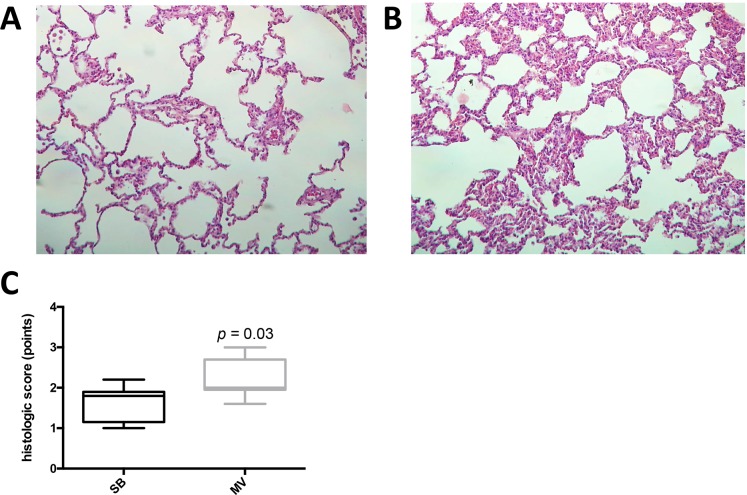
Rabbits exposed to injurious mechanical ventilation present signs of lung injury characterized by massive neutrophil infiltration.Representative lung histology (hematoxylin-eosin stain) in spontaneously breathing rabbits (A) and in rabbits submitted to mechanical ventilation for 4 hours (B). Histological lung injury score in rabbits submitted to mechanical ventilation compared to spontaneously breathing (SB) animals. Tissue injury was scored based on the degree of polymorphonuclear infiltration, hemorrhage, and edema in the interstitial and alveolar spaces on a scale from 0 to 3 points (C). Data represent median with interquartile range of at least three independent experiments. P < 0.05 as indicated, Mann-Whitney test. MV: mechanical ventilation, SB: spontaneously breathing.